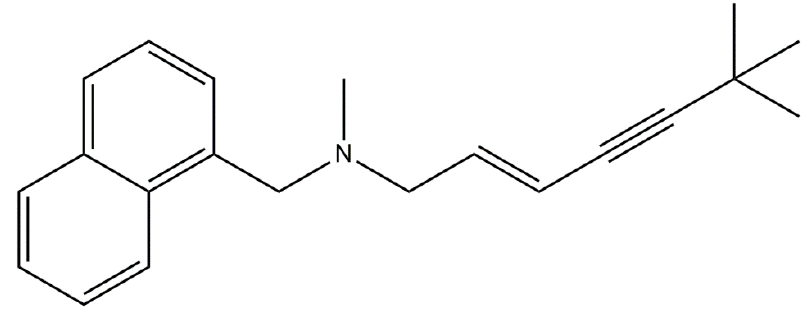
Figure 6. Chemical structure of Terbinafine.